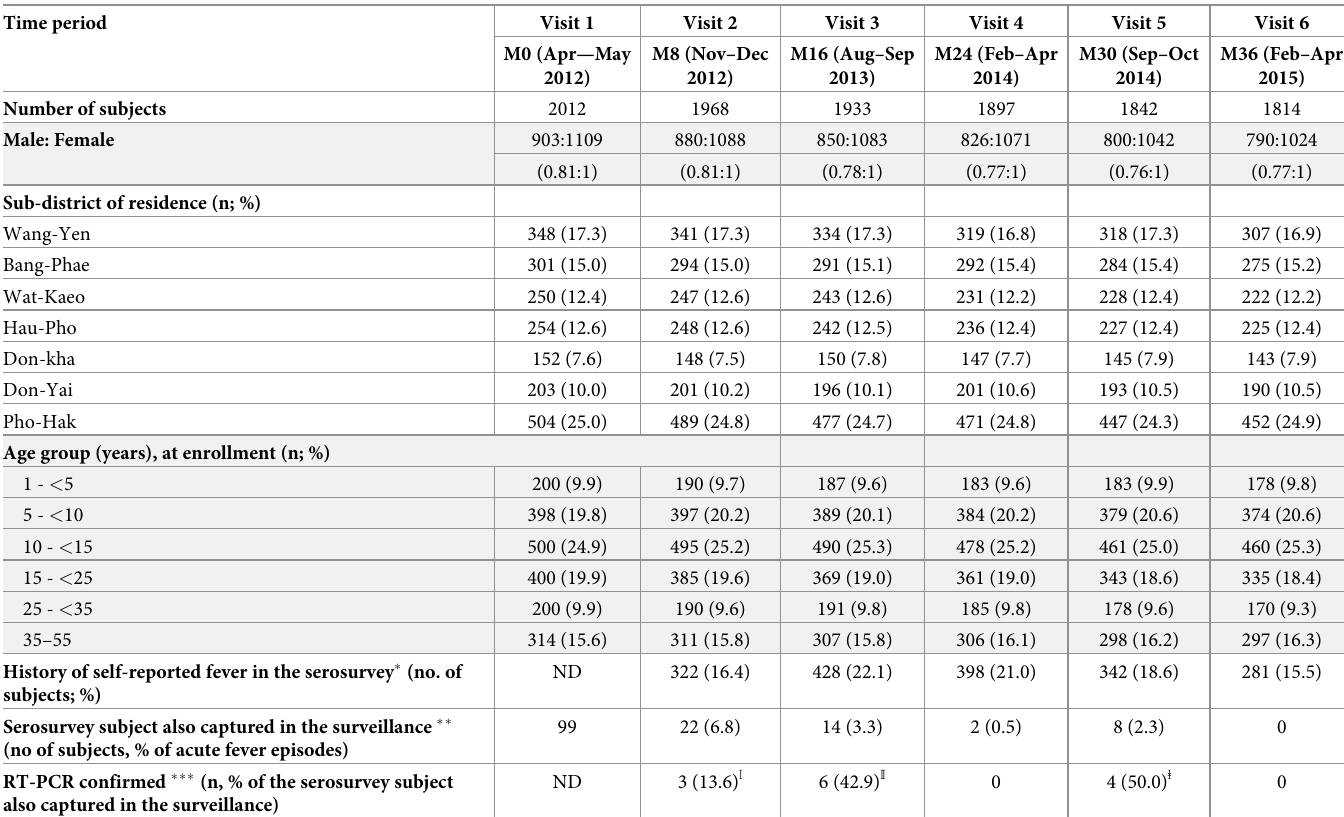
Table 1. Demographic characteristics of subjects by visit during the repeated (n = 6)